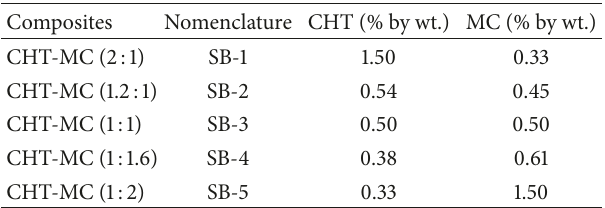
Table 1: Different weight ratio of chitosan (CHT) and modified Bijoypur clay (MC) in different composites.